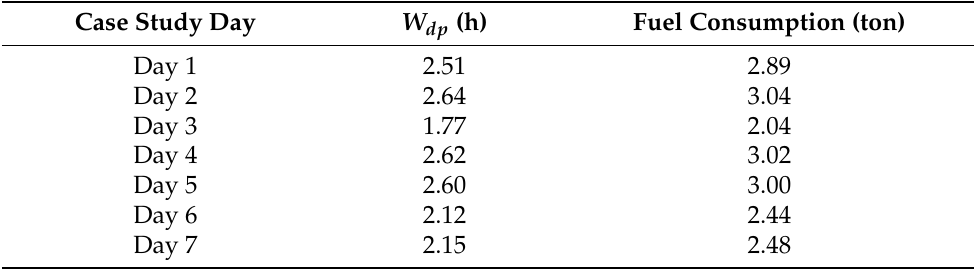
Table 5. Total departure delay in each of seven case study days. Case Study